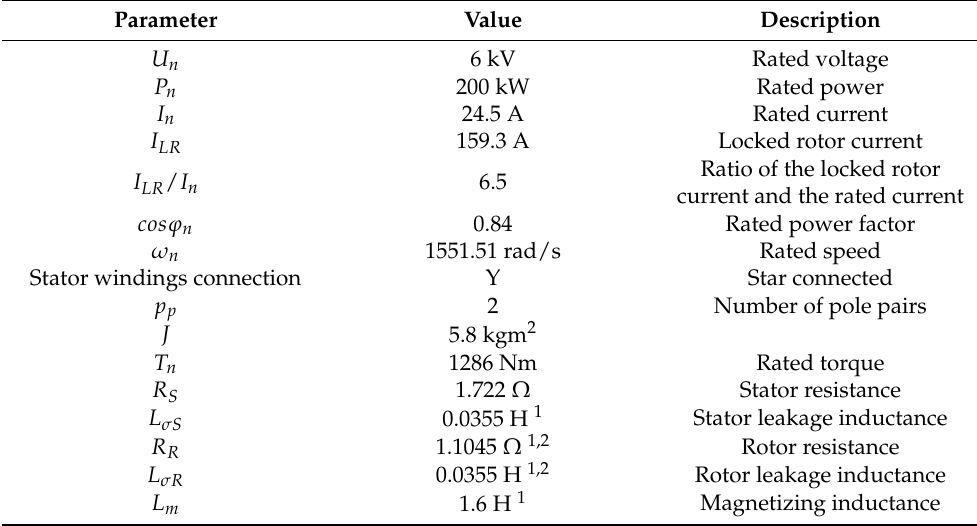
Table 1. Induction motor